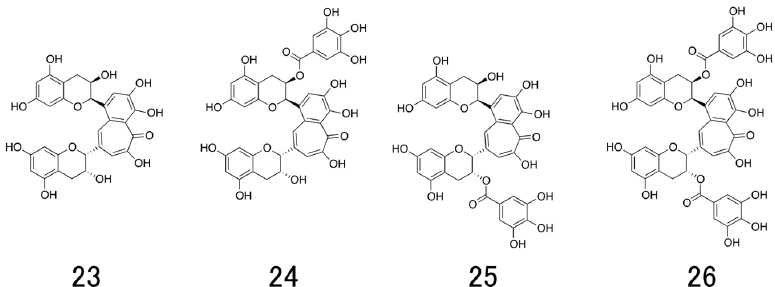
Figure 1. Chemical structures of natural catechins. ( − )-epigallocatechin-3- O -gallate (EGCG; 1 ), (+)-gallocatechin-3- O -gallate ((+)-GCG; 2 ), (-)-gallocatechin-3- O -gallate (( − )-GCG; 3 ), 5,7-dideoxy-EGCG (DO-EGCG; 4 ), epigallocatechin 3,5-digallate (EGCDG; 5 ), EGCG-thioether derivatives ( 6 ), EGCG-n-octadecylisocyanate derivative ( 7 ), EGCG-fatty acid monoester derivatives ( 8 ), EGCG-fatty acid tetra, octaester derivatives ( 9 ), ( − )-epicatechin-3- O -gallate (ECG; 10 ), ( − )-catechin-3- O -gallate (CG; 11 ), ( − )-epigallocatechin (EGC; 12 ), ( − )-gallocatechin (GC; 13 ), delphinidin ( 14 ), ( − )-epicatechin (EC; 15 ), ( − )-catechin (C; 16 ), 2 ′ ,2 ′ -bisepigallocatechin digallate (bEGCdG; 17 ), rhodisin ( 18 ), theasinensin A ( 19 ), P2 ( 20 ), epicatechin-3- O -gallate-(4 β → 8)-epicatechin-3- O -gallate ( 21 ), procyanidin B2 ( 22 ), theaflavin (TF; 23 ) theaflavin-3-gallate (TF-3-G; 24 ), theaflavin-3 ′ -gallate (TF-3 ′ -G; 25 ), and theaflavin-3,3 ′ - O -digallate (TFDG; 26 ).